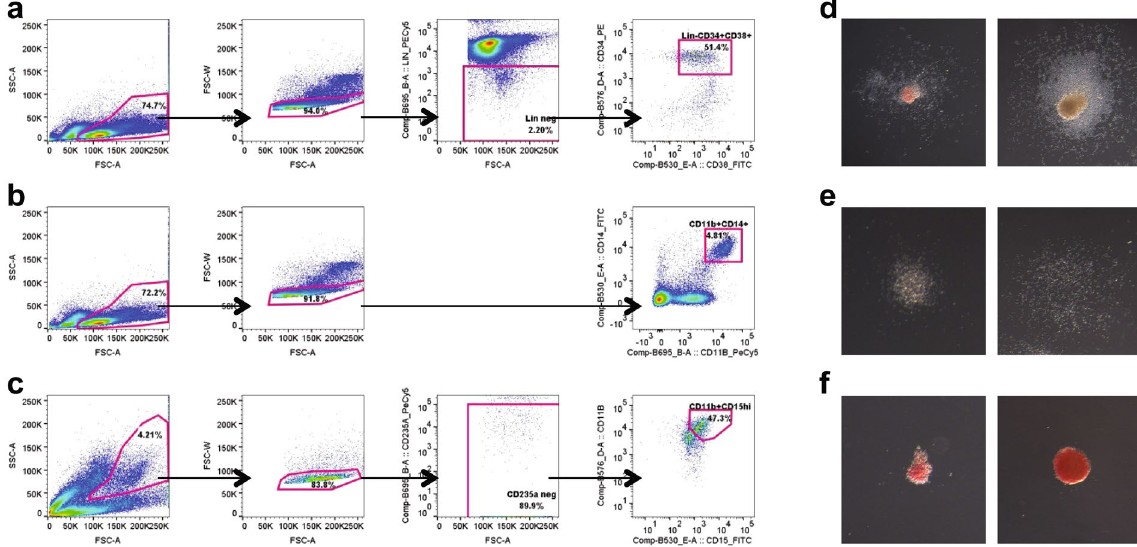
Figure 1. Purification of myeloid populations. ( a ) FACS gating strategy for purifying the CD34 + CD38 + myeloid progenitor populations. Firstly, mononuclear cells were gated on, then single cells, followed by lineage- negative cells. ( b ) Monocytes were identified as the CD11b + CD14 + cells within cord blood mononuclear cells. ( c ) Polymorphonuclear cells were isolated by dextran separation from red blood cells. Granulocytes were then sorted and were identified as the CD11b high CD15 high cells, following exclusion of CD235a + red blood cells. ( d – f ) Myeloid progenitors were plated in semi-solid Methocult medium with the cytokines SCF, IL-3, GM-CSF and EPO. Colony types formed include colony forming unit-granulocyte/erythrocyte/monocyte/macrophage ( d , left), granulocyte/macrophage ( d , right), granulocyte ( e , left), macrophage ( e , right), erythrocyte ( f , left) and blast forming unit-erythrocyte ( f , right). Note: Images d – f are on different scales to emphasize morphological